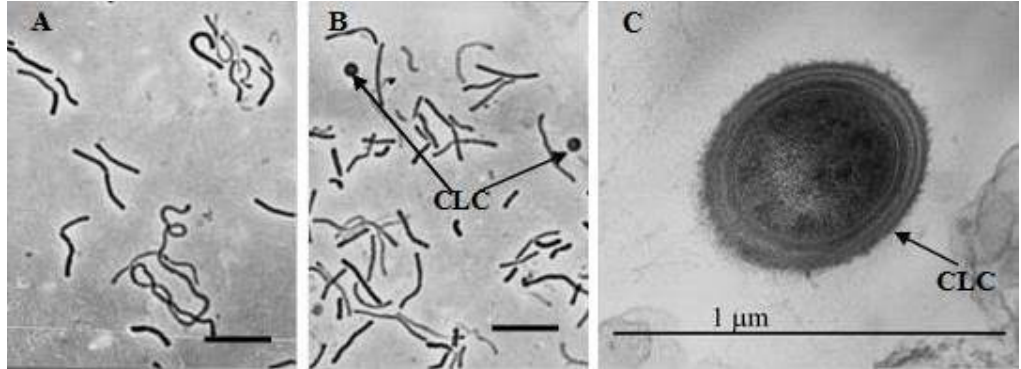
Figure 5. Micrographs of strain M. arcticum M2 T cells without perchlorate ( A ) and with Mg(ClO 4 ) 2 in the medium ( B , C ): A , B —phase contrast, bar 10 µm; C —ultrathin section. Abbreviations: CLC—cyst-likes